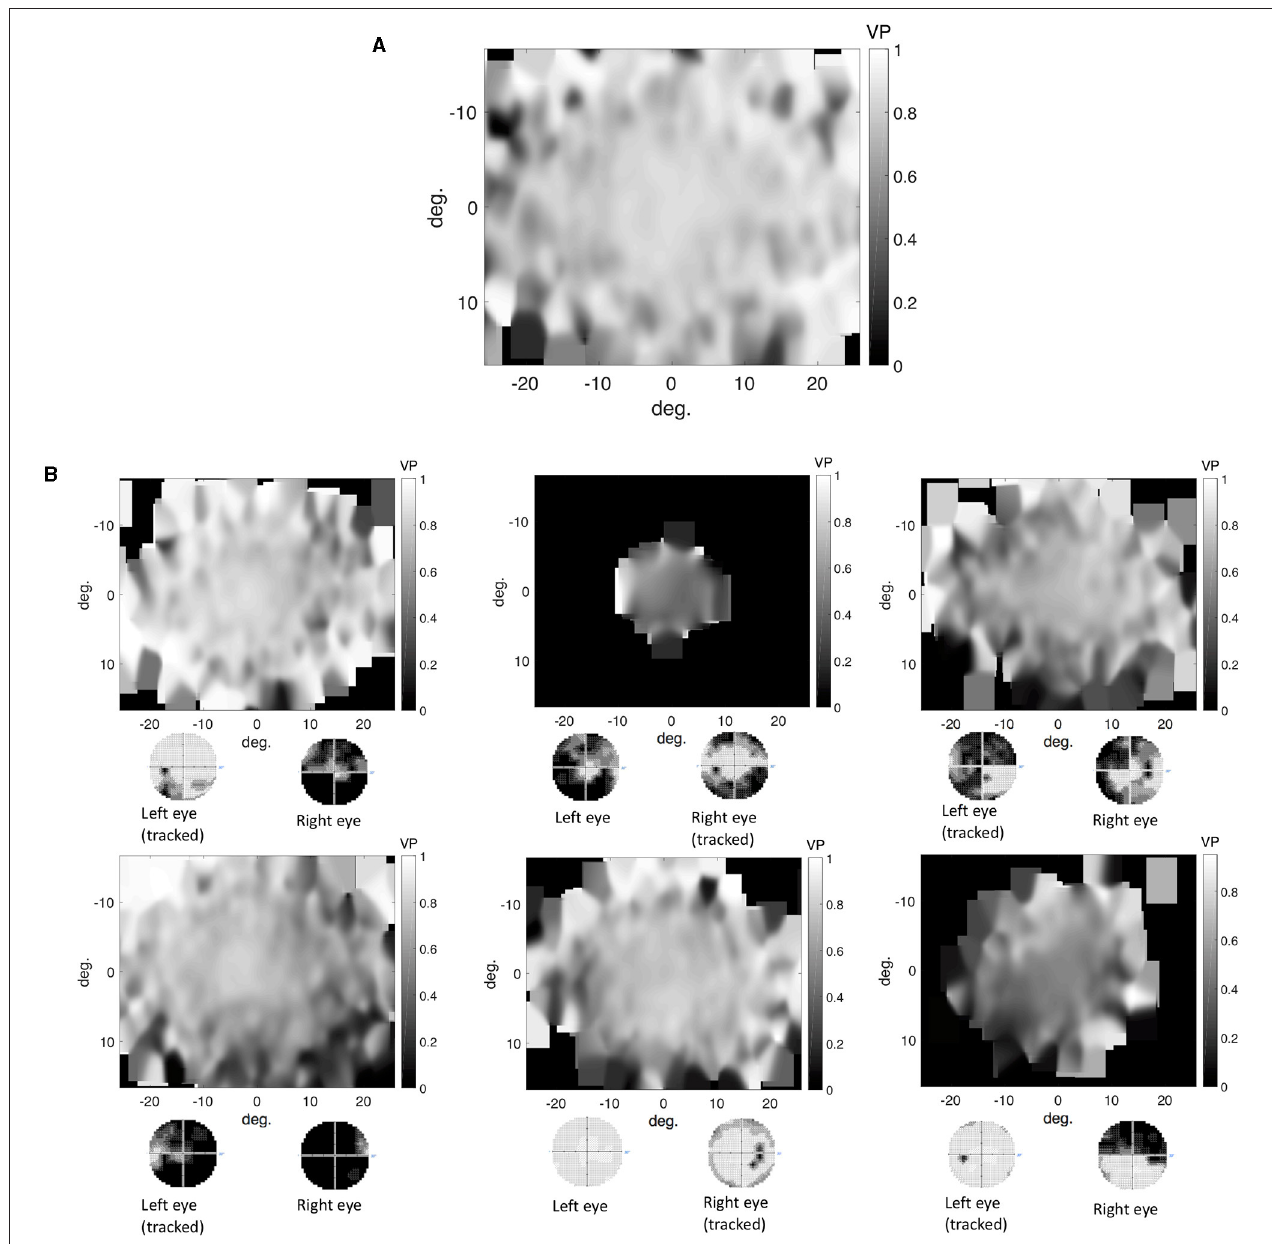
FIGURE 6 | (A) Representative example of the distribution of VP across the visual field of a control participant. (B) Representative examples of VP maps of participants with different types of VFD. The distribution of the VP usually does not correspond to the sensitivity values of the visual field, except for the participant with tunnel vision, which is due to the fact that they never direct their gaze toward the periphery and therefore have a VP of 0 in these